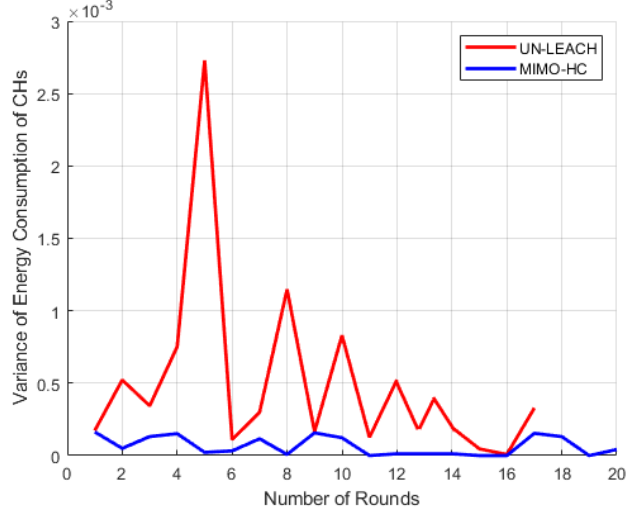
Figure 11. Divergence of energy depletion among cluster heads. By contrast, cluster heads in MIMO-HC communicate with the central station through mixed hop (i.e., multi and single hops), and use sub-optimal routes among the cluster heads and the central station. As such, they transmit data via sub-optimal paths chosen at random which enable them to save a considerable amount of energy. Furthermore, the energy efficiency of our proposed model is investigated by evaluating the lifespan of the network (see Figure 12). Figure 12 displays the time at which the first and the final nodes die. As compared with the UN-LEACH, the MIMO-HC improves the time until both the first node and the final node